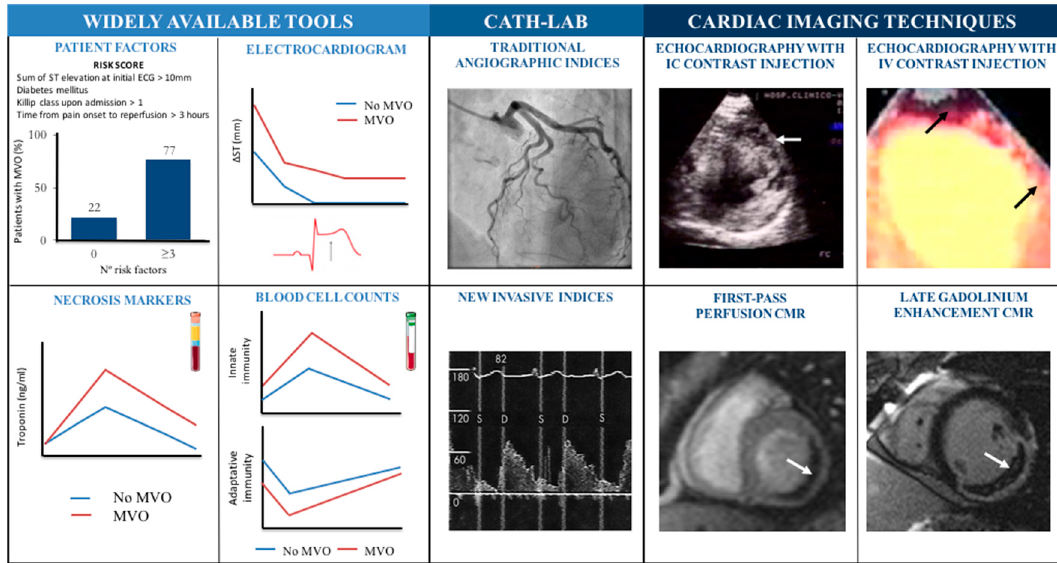
Figure 3. Diagnostic tools to detect the presence of microvascular obstruction (MVO) in patients with ST-segment elevation myocardial infarctions. The identification of MVOs can be accomplished using di ff erent tools, classified as: widely available tools (left); catheterization lab (central): traditional angiographic indices (TIMI and TIMI frame count indices, “TIMI myocardial perfusion grade”, or “myocardial blush grade”) and new invasive indices (reserve of coronary flow velocity, the diastolic deceleration time of coronary flow velocity, or the presence of systolic flow inversion); and cardiac imaging techniques (right). See text (Section on “diagnostic tools”) for further information on each specific item. Arrows point at areas with MVO. Innate immunity cells are considered neutrophils and monocytes, whereas adaptative immunity is comprised of lymphocytes and eosinophils. CMR = cardiovascular magnetic resonance; IC = intracoronary; IV = Intravenous; PCI = primary coronary intervention; TIMI = thrombolysis in myocardial